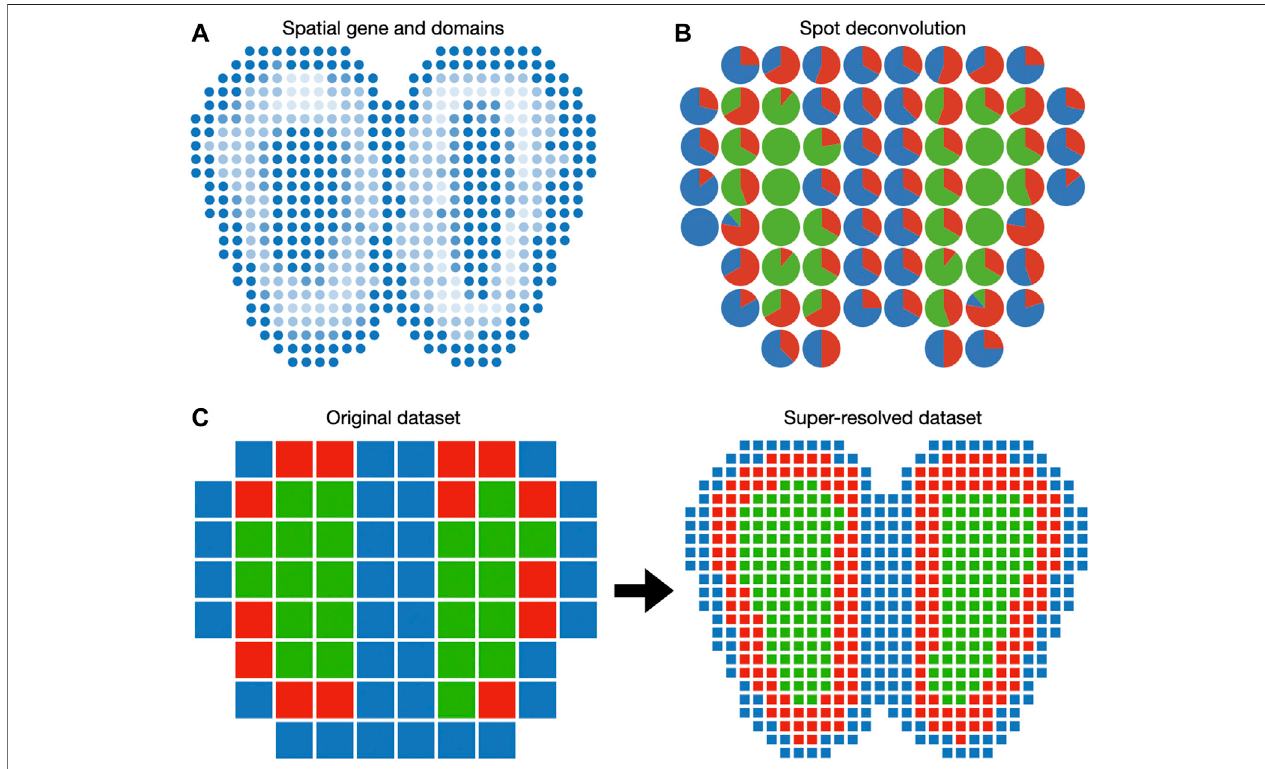
FIGURE 3 | Visualization of gene expression in the Euclidean space. (A) Spatially coherent genes and spatial domains can be visualized as 2D images. (B) Spot deconvolution methods estimate the proportion of each cell type within each spot. Pie charts are routinely used to represent cell type proportions within each spot. (C) Spot super-resolutionmethodsestimate thecelltypeofsub-pixelsbasedoncorrelation withneighborspots. Inthiscase,each spotoftheoriginaldatasetisdividedinto nine spots in the super-resolved dataset.